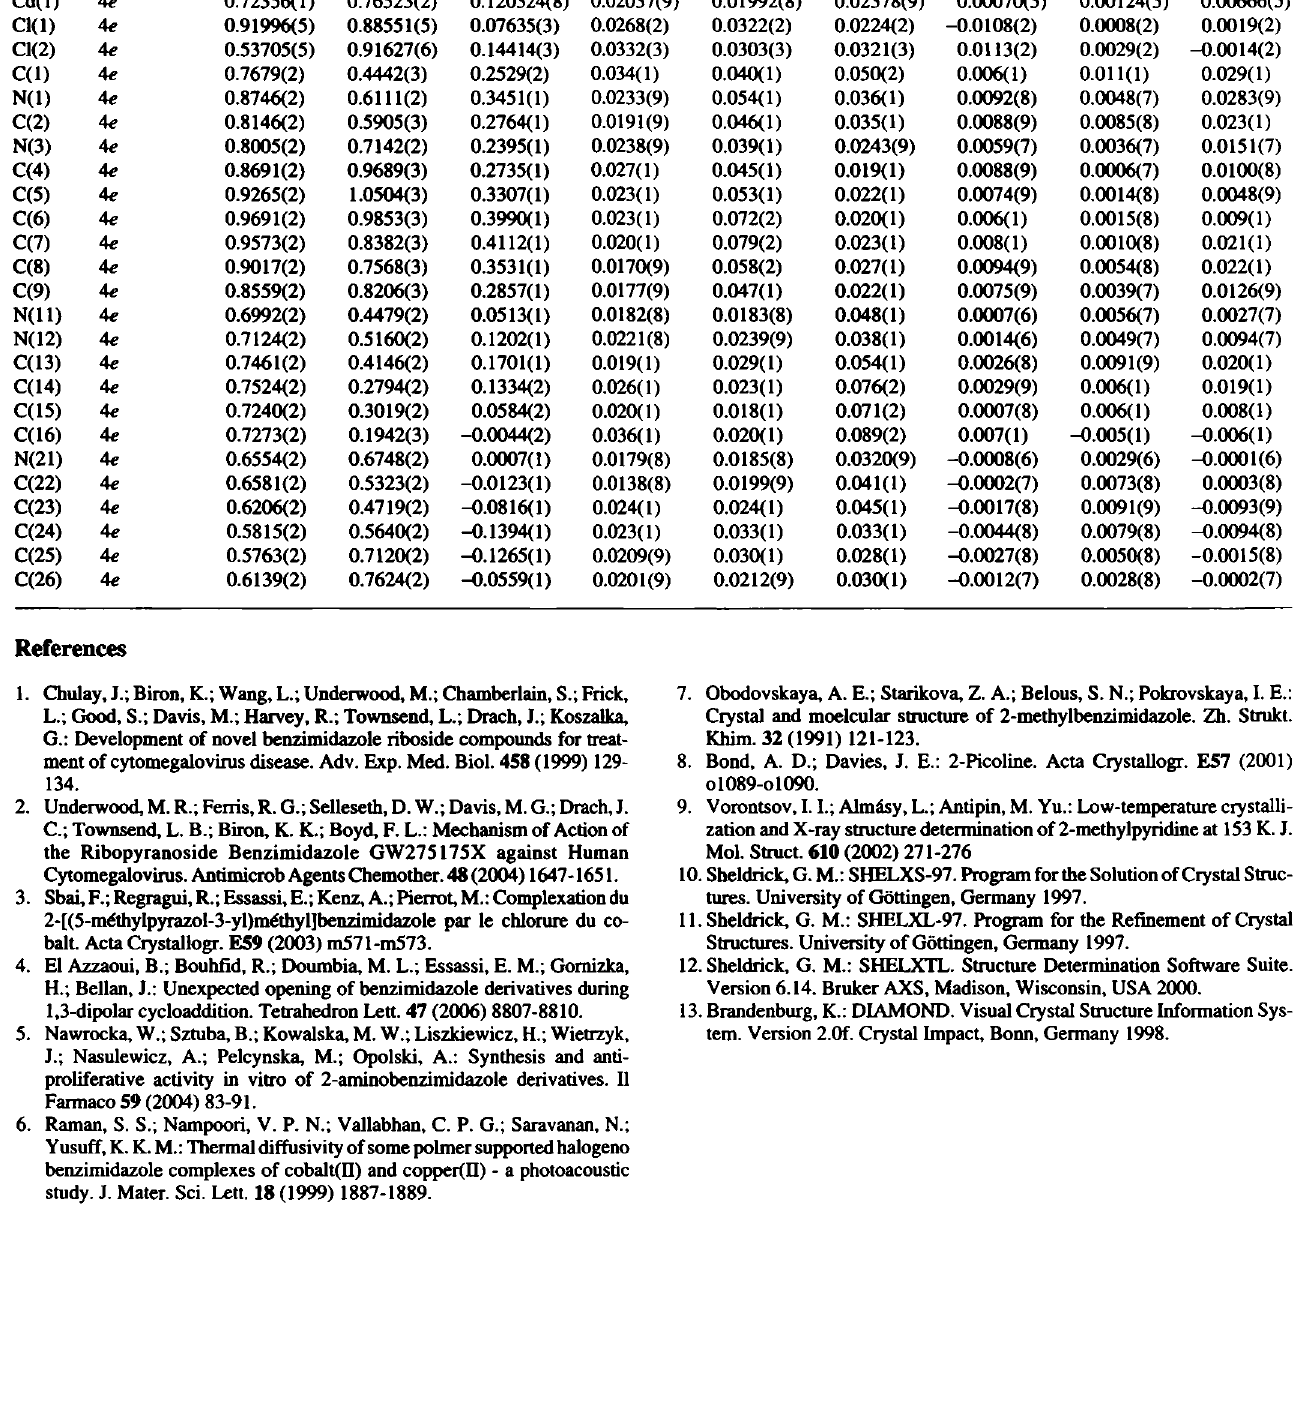
Table 3. Atomic coordinates and displacement parameters (in Â 2